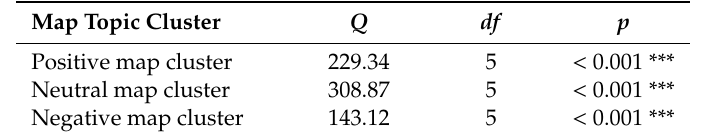
Table 2. Results of Durbin-Skillings-Mack analysis of symbol-content congruence by three map